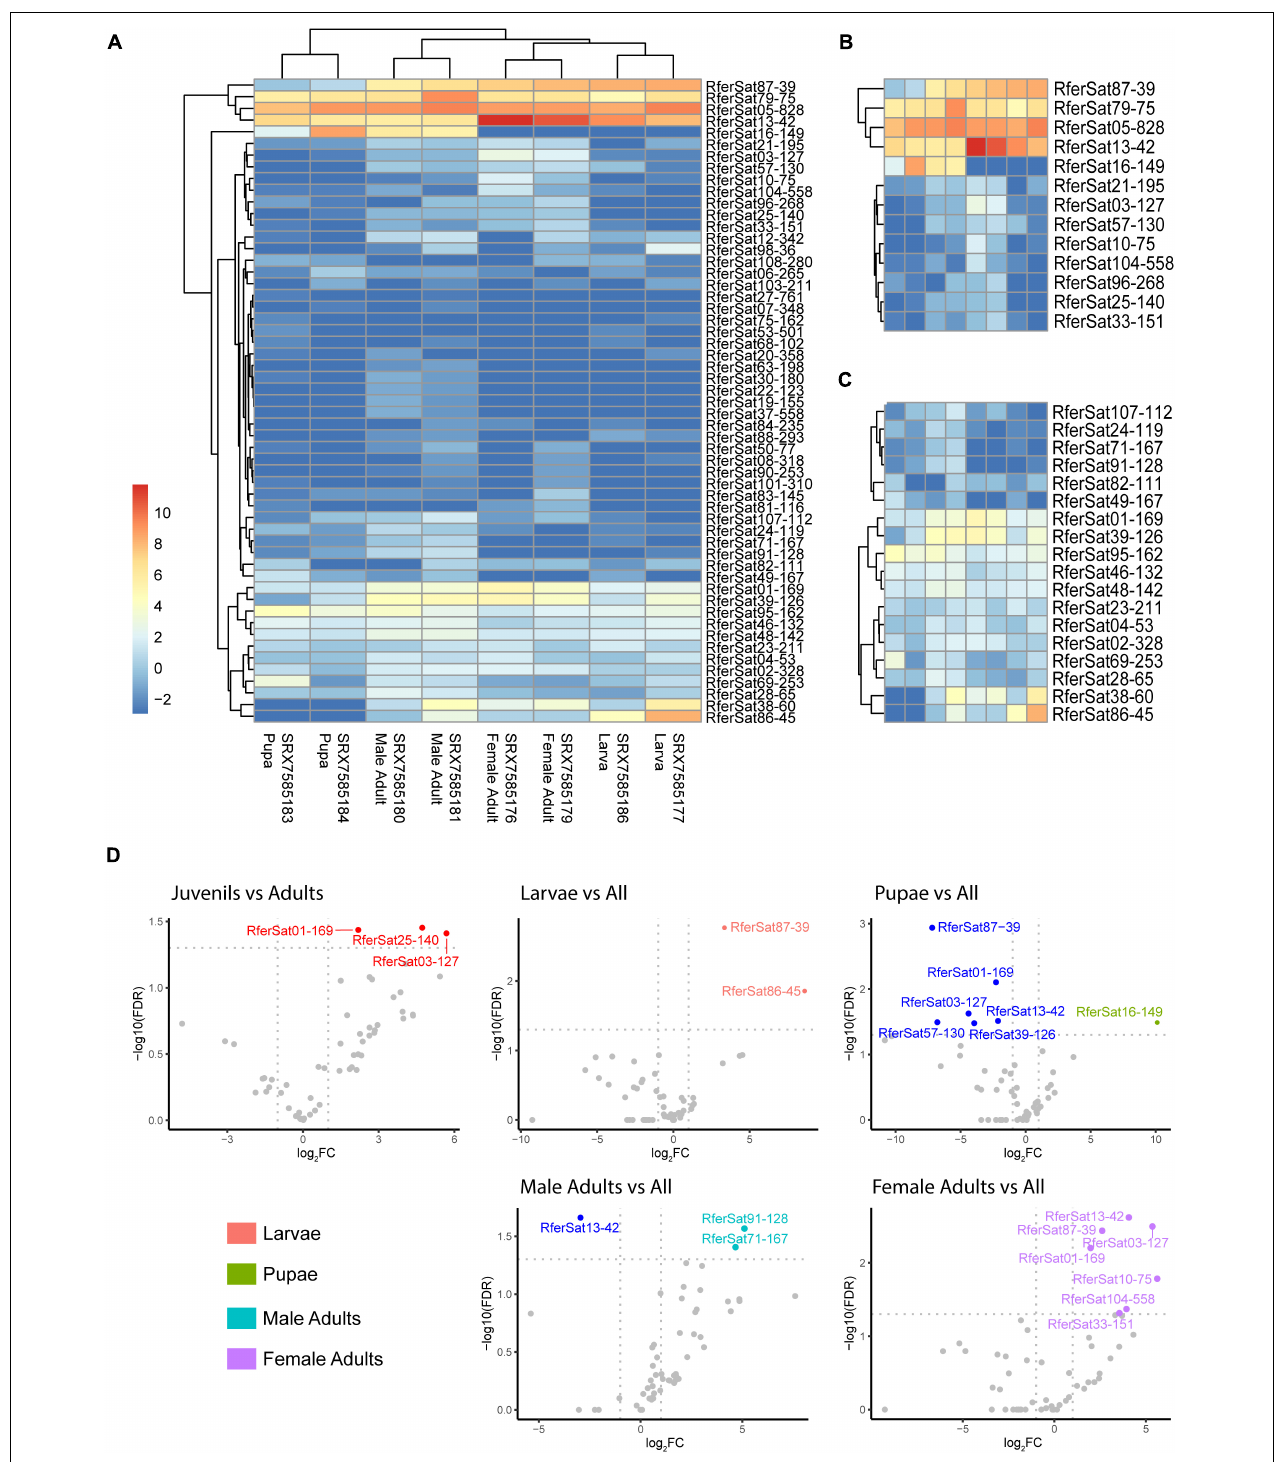
FIGURE 5 | Transcription of satDNA families of Rhynchophorus ferrugineus across the development. (A) Heatmap with satDNA family expression. Samples were clustered by stage according to their expression profiles. (B) Top of the heatmap with the highly expressed satDNA families. (C) Bottom of the heatmap with moderated expressed satDNA families. (D) Differential expression in different stages compared to the rest. Downregulated satDNA families are indicated in blue and upregulated satDNA families in the color of each stage.